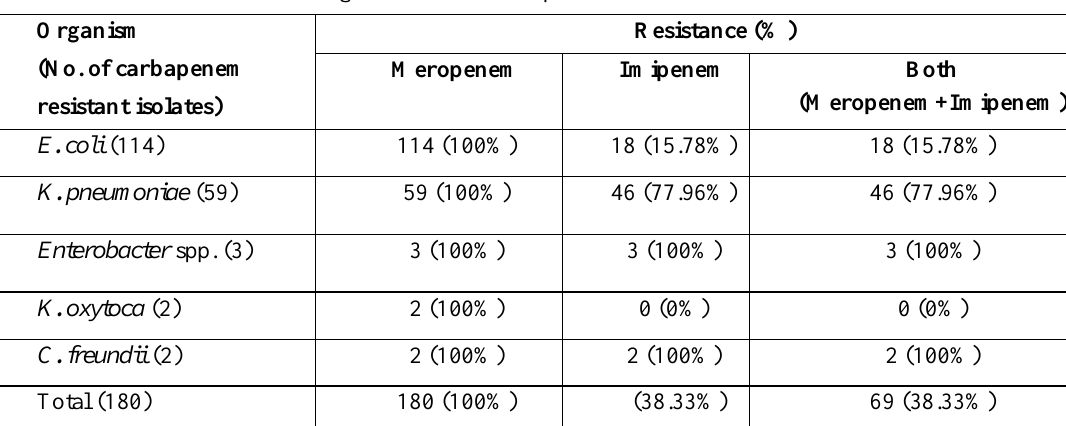
Table 1. Bacterial isolates showing resistance to